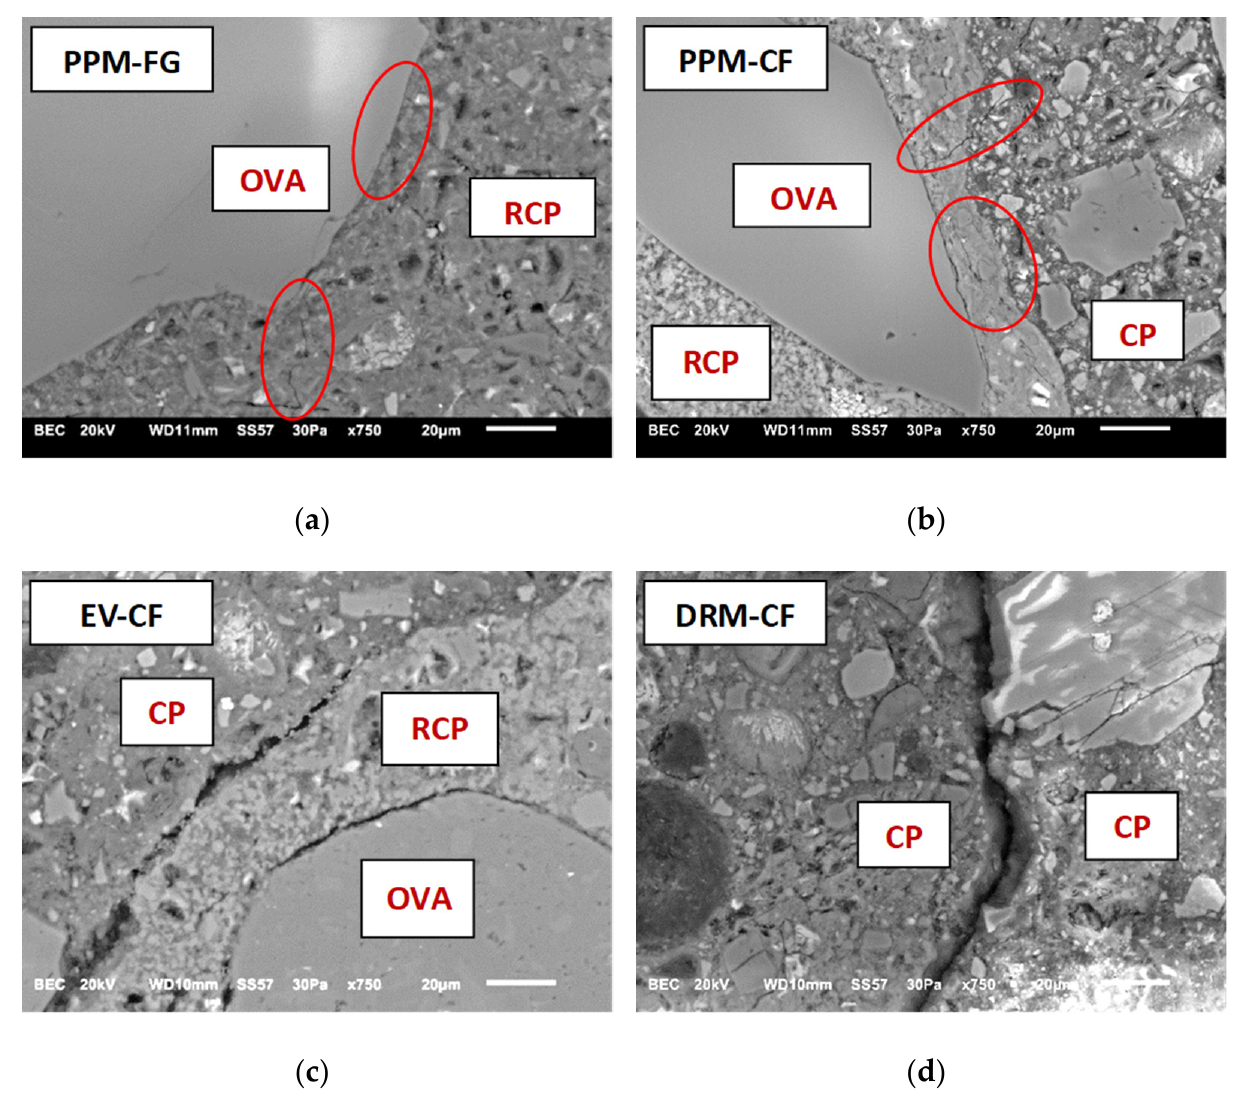
Figure 14. SEM micrographs of the old and new ITZs present in different RCA mixtures designed by ( a ) PPM-NS-CF, ( b ) PPM-NS-FG, ( c ) EV-NS-CF and ( d ) DRM-NS-CF—BSE images at a magnification of 750×.